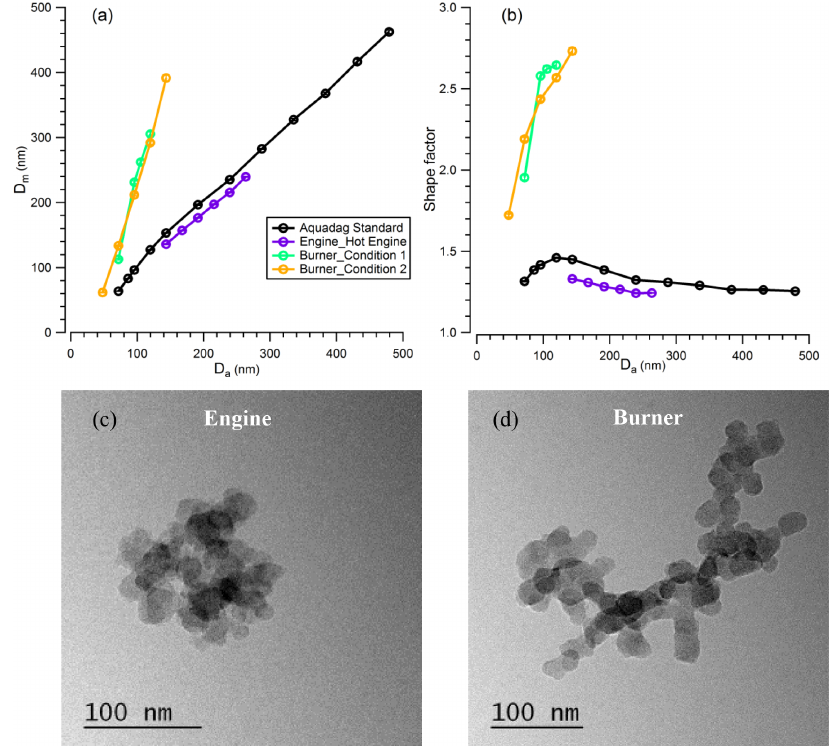
Figure 7. Relationship of (a) mobility size with aerodynamic size and (b) shape factor with aerodynamic size, of BC particles from Aquadag standard atomisation, diesel engine and flame burner emission; TEM images of BC particles emitted from (c) a diesel engine (hot engine condition) and (d) a flame burner (condition 1). The error bar in (a) and (b) is too small to see clearly.